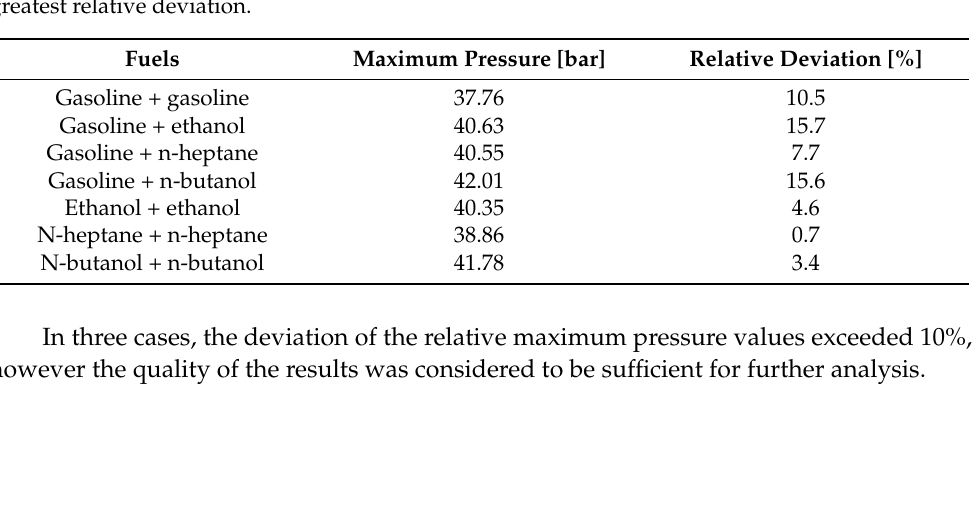
Table 7. Maximum combustion pressure values for representative characteristics, including the greatest relative deviation.